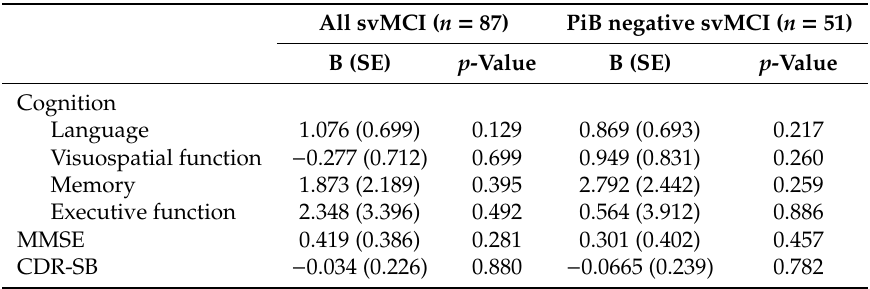
Table 3. Longitudinal change of cognitive function in the WMH progression group compared with the WMH regression